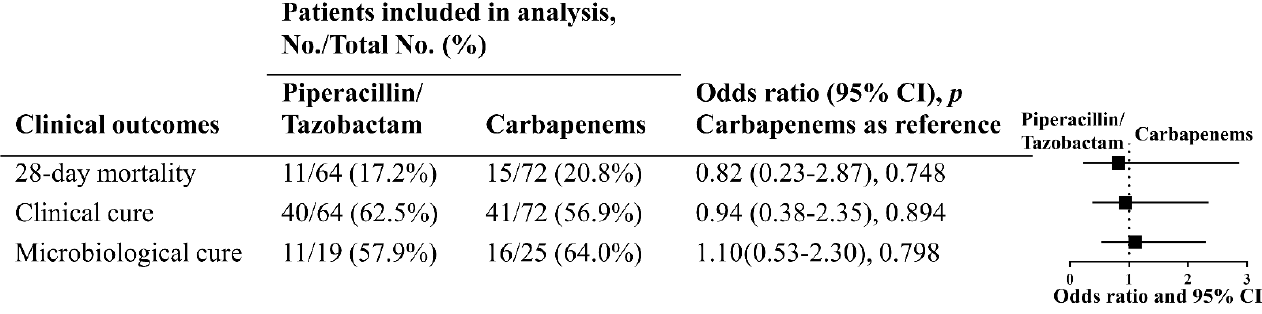
Figure 3. Clinical outcomes in patients with nosocomial pneumonia caused by ESBL-producing K. pneumonia . In the weighted cohort, the 28-day mortality was 17.4% vs. 18.5%, and the clinical cure was 63.8% vs. 62.2% in patients receiving piperacillin/tazobactam and carbapenems, respectively. The odds ratio and 95% confidence intervals for the 28-day mortality and clinical cure were calculated in the weighted cohort adjusting for age, APACHE II score, and type of pneumonia. The OR and 95% CI for the microbiological cure were estimated in the microbiologically evaluable cohort.